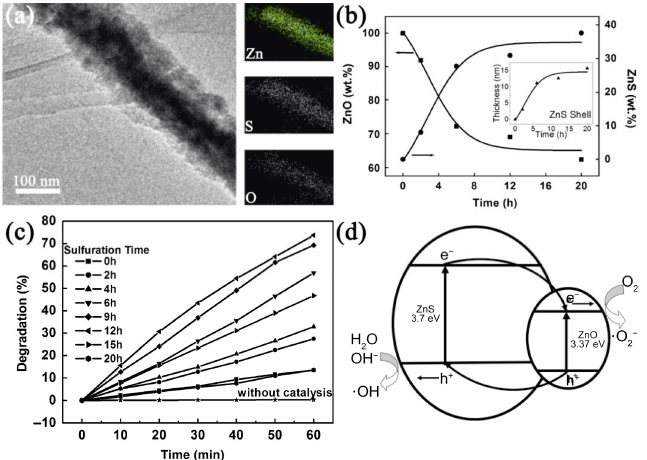
Figure 12. ( a ) The morphology and elementary distribution of ZnO-ZnS nanofibers; ( b ) dependence of phase contents on sulfuration times (inset shows the relationship between the thickness of the ZnS shell and the sulfurating time); ( c ) kinetics of the photodegradation of RhB by ZnO–ZnS nanofibers that were sulfurized for various times; ( d ) proposed schematic illustration of the band structure- related photocatalytic mechanism of the ZnO–ZnS heterostructure nanofibers. (Redrawn with the permission of Ref. [39]. Copyright 2010 John Wiley and